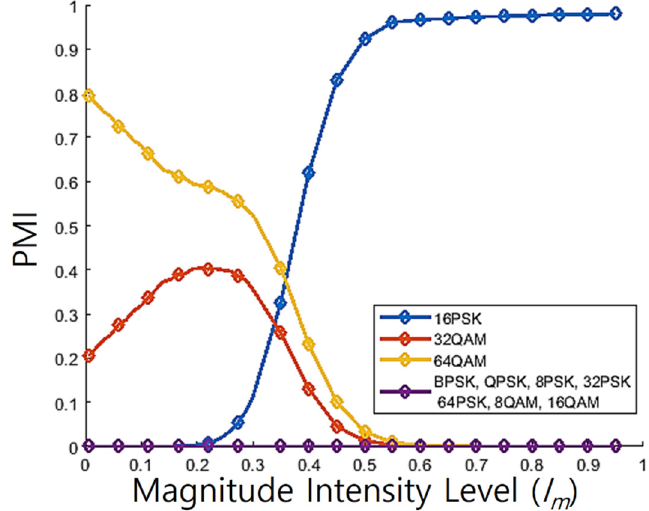
Figure 17. PMI evaluation with varying I m and I p =